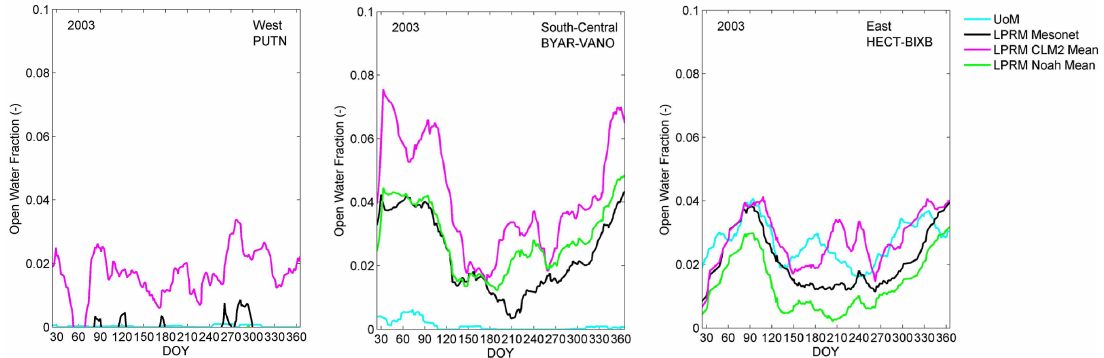
Fig. 5. Time series of the Open Water Fraction calculated with the LPRM, together with the OWF UoM , for the 0.25 ◦ grids cells in the Western, South-Central and Eastern Oklahoma area (low-pass filter 14